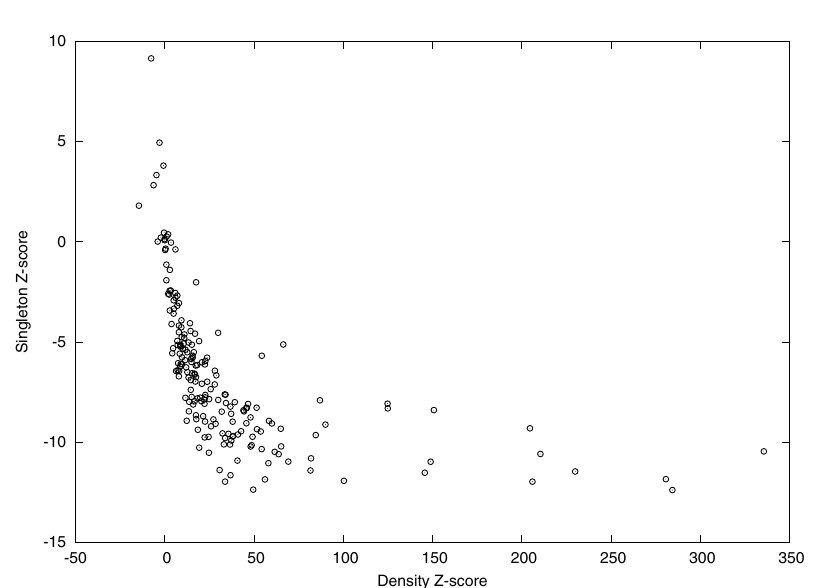
Figure 7. Correlation between diagonal Z values (x-axis) and z 0 values (y-axis). Each point represents a given functional class of a given